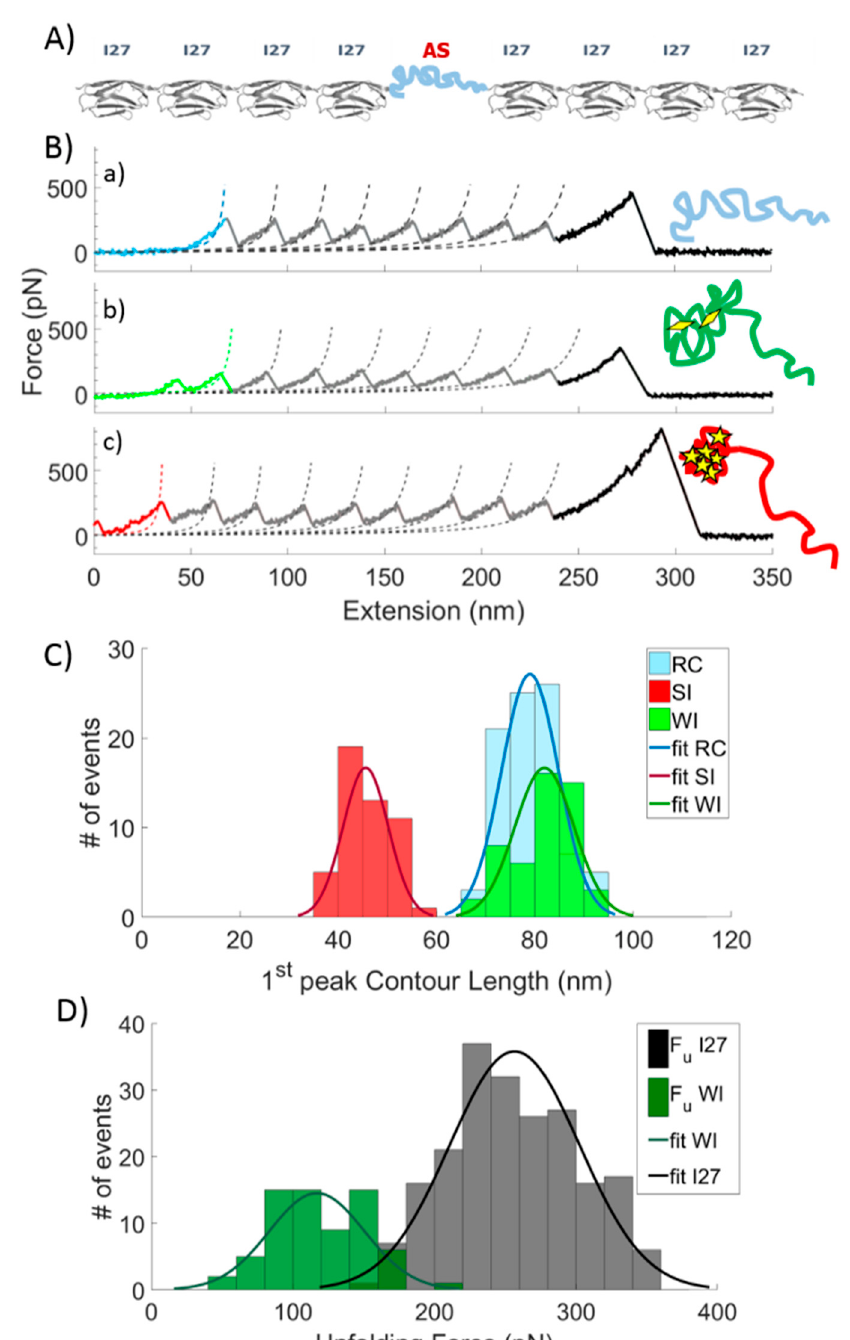
Figure 1. Representative single molecule force spectroscopy (SMFS) recording of α -synuclein (AS) polyprotein and relative statistical analysis. ( A ) Polyprotein construct encompassing the AS full-length polypeptide chain for SMFS experiments. ( B ) Representative force curves of the mechanical unfolding of the polyprotein in distinct conformations stabilized by RC (a), WI (b), and SI (c). Dotted lines are worm-like-chain (WLC) fits to the force-extension curves with free contour length L C and a fixed persistence length L p = 0.36 nm (see Figure S2 for raw data). Sketches of AS conformations are shown on the right. Diamonds represent weak interactions stabilizing the AS protein, while stars represent strong interactions. ( C ) Statistical distribution of the contour length of the first peak for RC (L C = 79 ± 6 nm), WI (L C = 82 ± 6 nm), and SI (L C = 46 ± 5 nm) conformations. Solid lines represent the Gaussian fits of the histograms. ( D ) Unfolding force statistical distribution of WI (F WI = 117 ± 34 pN) and I27 modules (F I27 = 257 ± 46 pN).